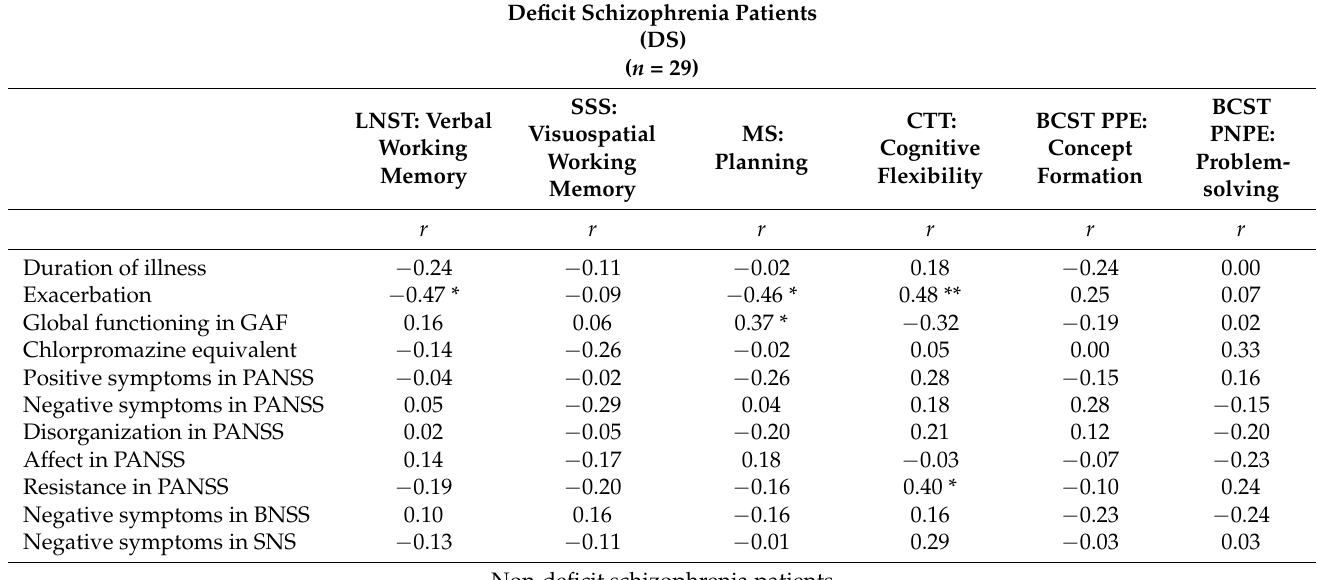
Table 4. Relationship between clinical factors, psychopathological symptoms, and different aspects of executive functions in the two patient